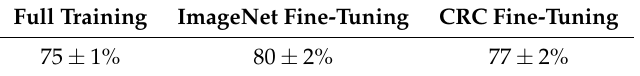
Table 4. Pleural tissue classification accuracy (%). Comparing cross-domain and intra-domain transfer learning